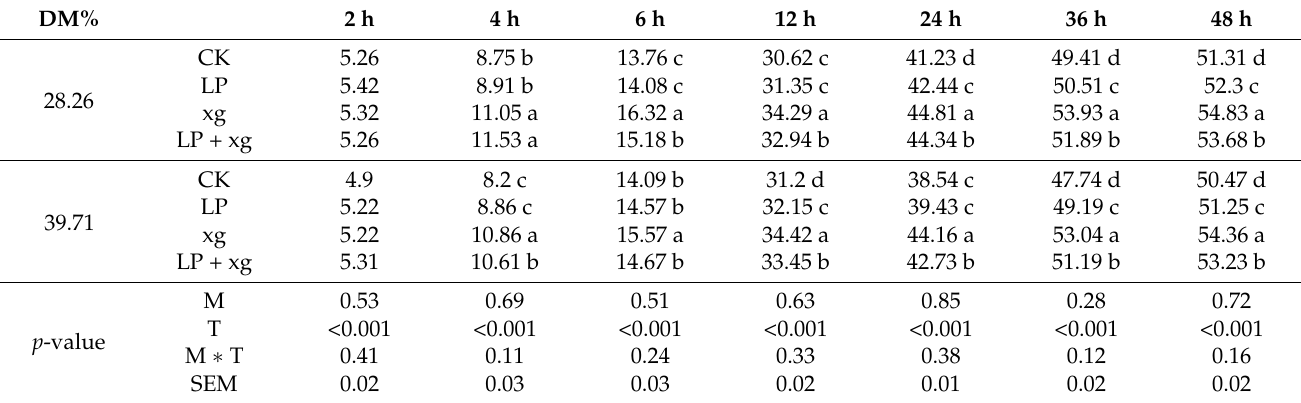
Table 10. Effects of moisture content and additives on in vitro gas production of Stylosanthes